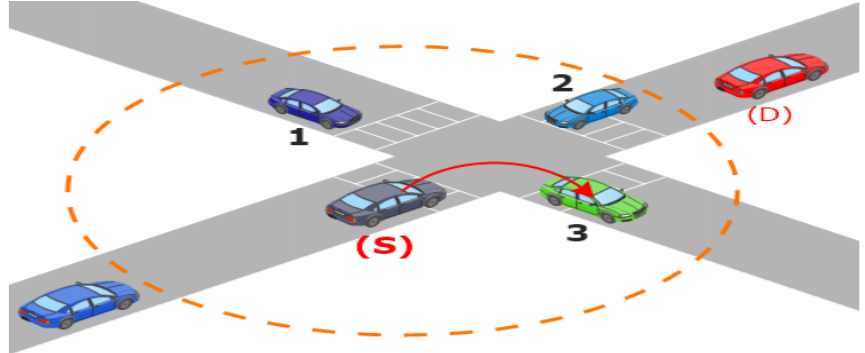
Figure 5. Choosing the next hop in the SecE-V2X protocol.